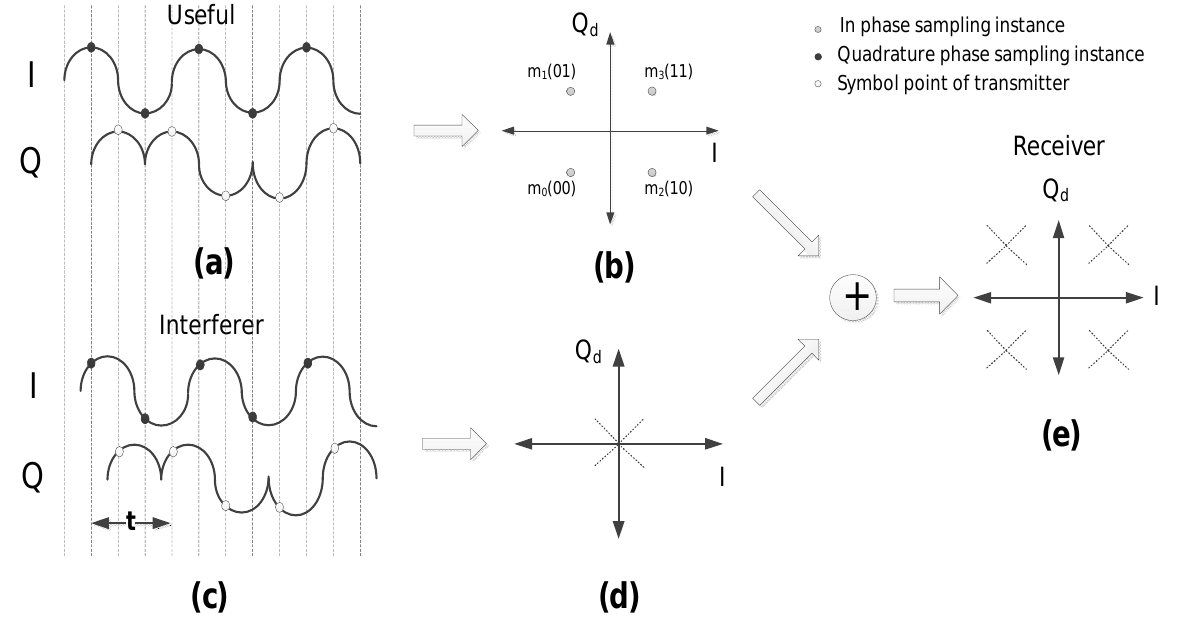
Figure 3. The impact of of the interferer: the asynchronous case. ( a ) Useful signal; ( b ) Q domain representation of useful signal; ( c ) Interferer signal; ( d ) Q of interferer signal; ( e ) Q -I domain representation of received d